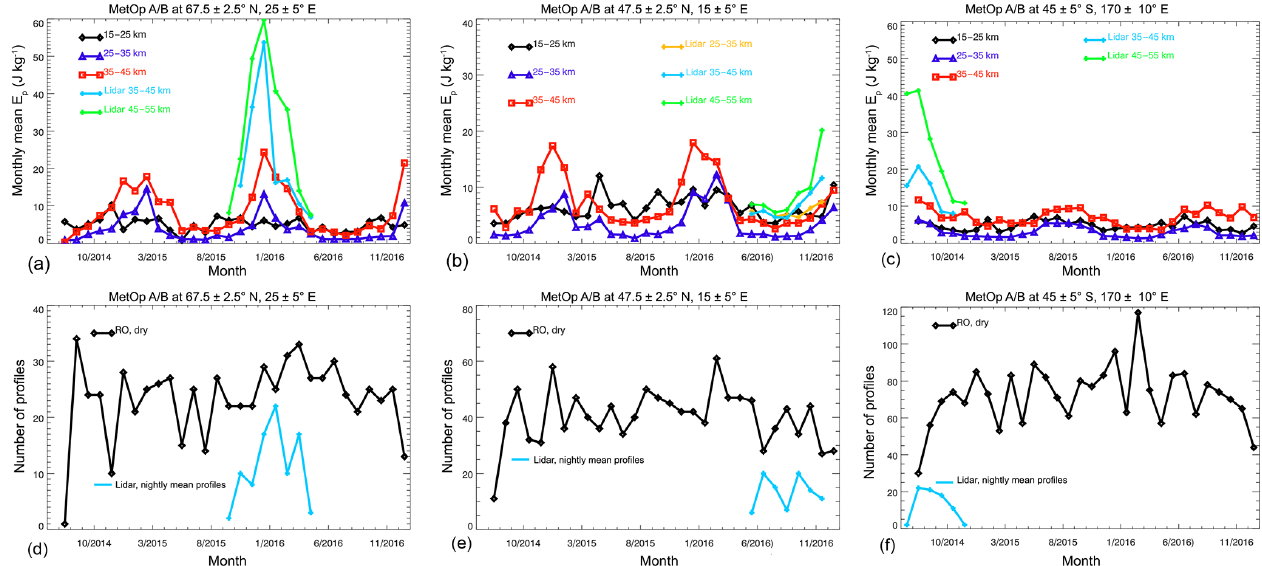
Figure 8. (a–c) Comparison of time series of monthly mean E P from METOP RO data for different altitude ranges (black, blue, and red curves; see insert for color code) with local Rayleigh lidar measurements of E P for the stations of Sodankylä (a, d) , the Bavarian Forest (b, e) , and Lauder (c, f) . Lidar E P are shown as yellow (25–35km), light blue (35–45km), or green (45–55km) lines. (d–f) Number of RO profiles (black lines) and nightly mean lidar profiles (light blue lines) entering the monthly mean shown in the panels above.